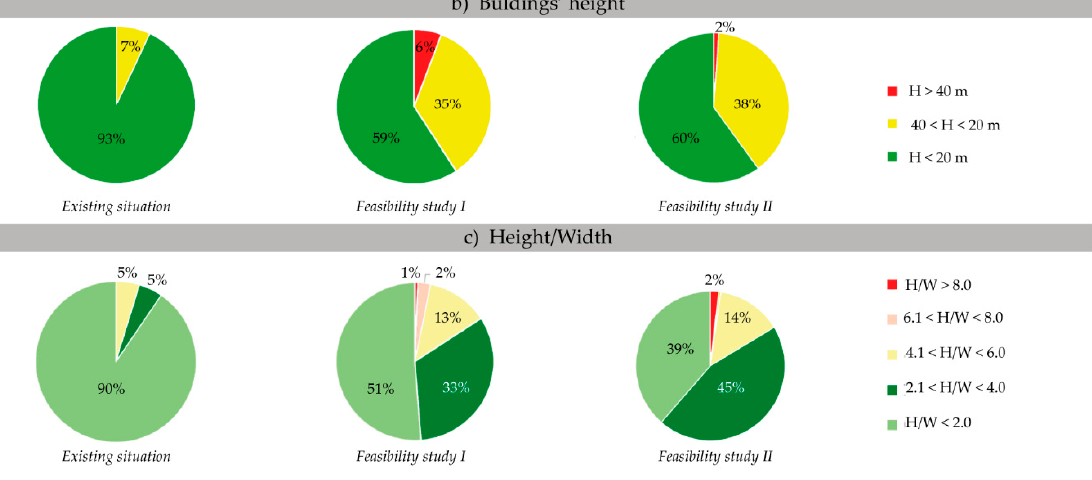
Figure 9. Urban analysis of Sluppen area: ( a ) BRA (m 2 ); ( b ) building height (m); ( c ) H/W analysis.